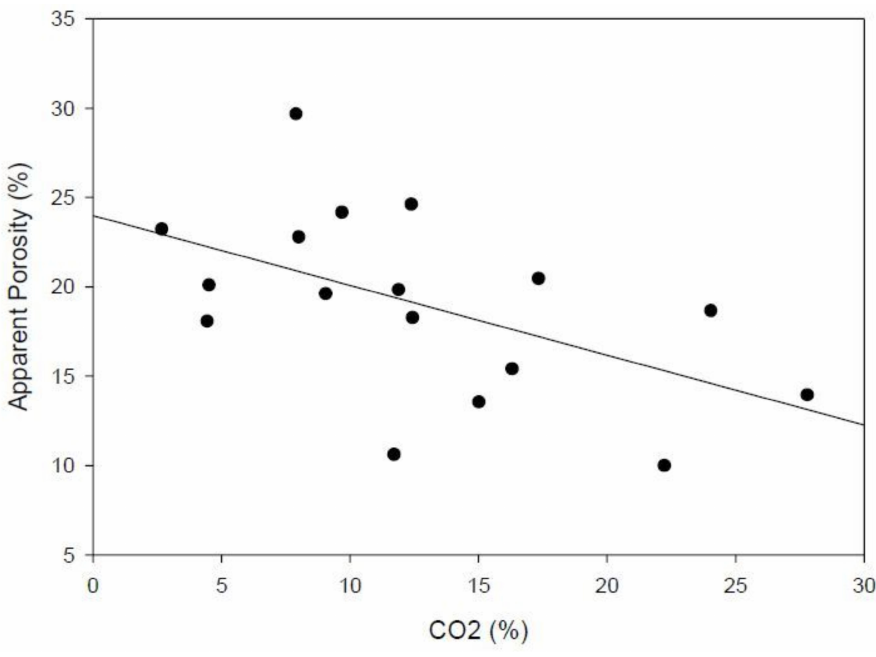
Figure 10. Relationship between measured porosity and carbonate (measured CO 2 ) content in conglomerates of the Trekoppje palaeochannel [30].